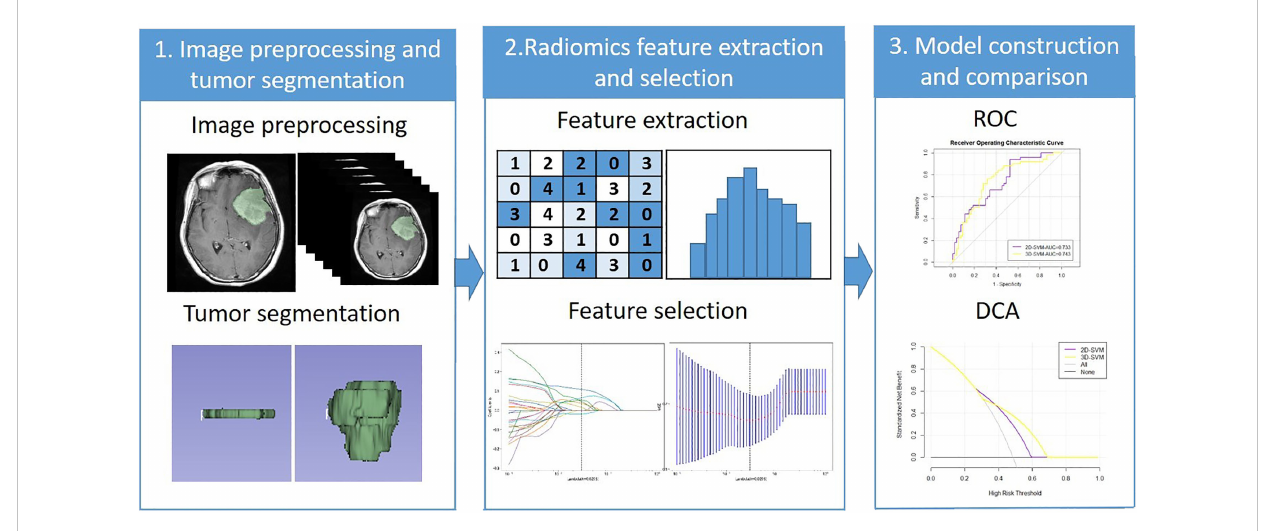
FIGURE 2 The radiomics work fl ow. ROC, Receiver operating characteristic; DCA, Decision curve